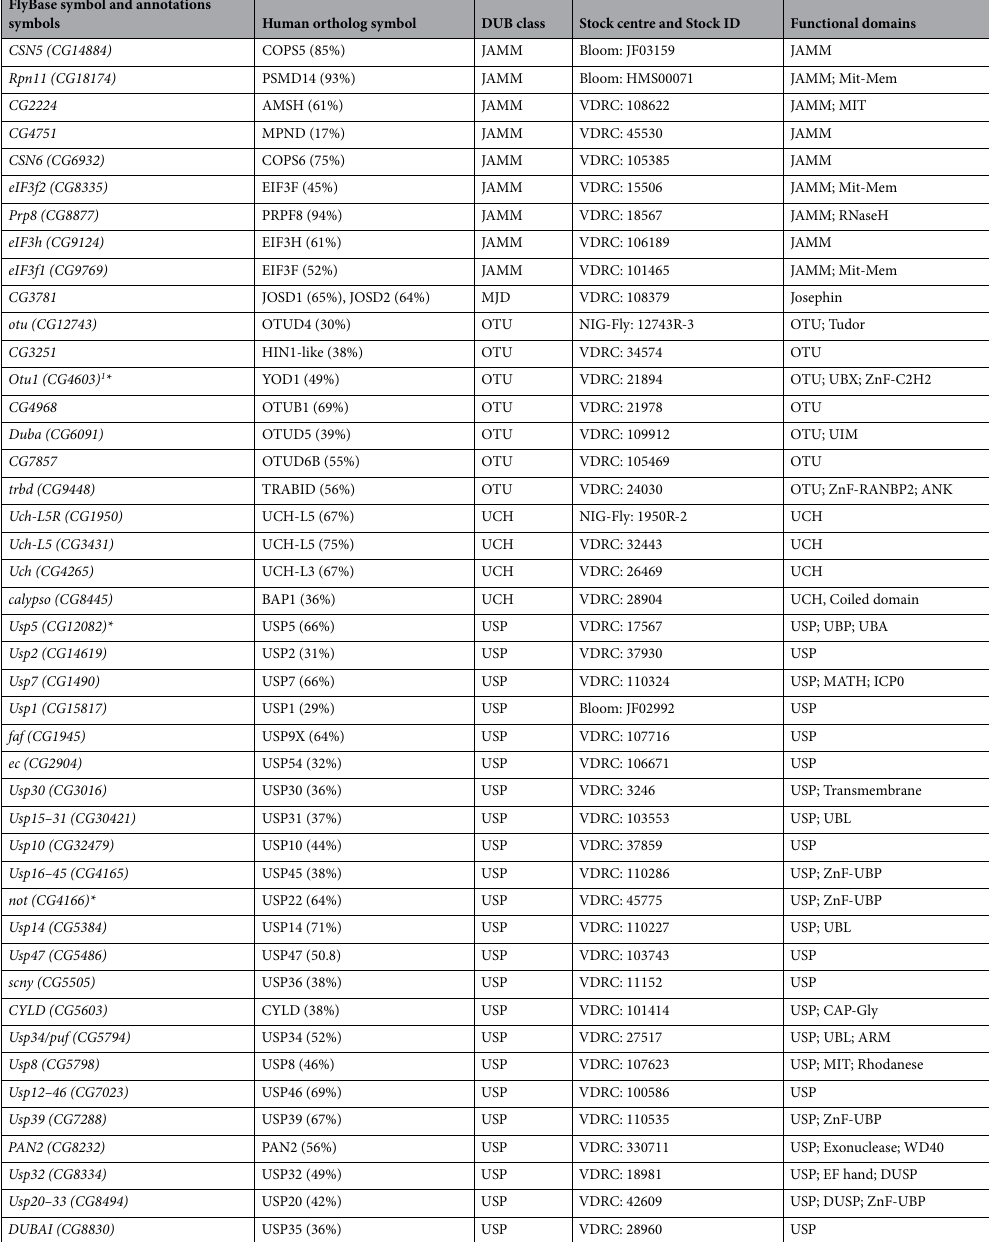
Table 1. A 44 Drosophila DUBs were selected for further tests in the RNAi screening. FlyBase symbol represents gene names based on the FlyBase database and next to FlyBase symbols, annotation symbols are labeled with CG numbers. Those DUBs which are annotated only with CG-prefixed numbers are labeled with a CG-prefix number only in FlyBase symbol and annotation symbols column. The second column shows the annotated human orthologs of the Drosophila DUBs. Next to the human orthologs, the average identity between Drosophila and human orthologs was labeled in brackets. The Stock centre and Stock ID column contains the ID number and the abbreviated name of the stock centre as follows: the Bloomington Drosophila Stock Center is labeled as Bloom, the Vienna Drosophila Resource Center is denoted to VDRC and the National Institute of Genetics is referred to as NIG-Fly. The last column, depicting the Functional Domains, demonstrates the conserved functional domains where the short names of domains are labeled as follows: ANK Ankyrin repeats domain, ARM armadillo repeat domain, CAP-Gly cytoskeleton-associated protein glycine-rich, DUSP domain in USP, ICP0 Infected cell protein 0, JAMM JAB1/MPN/Mov34 metalloenzyme, MATH meprin and TRAF homology domain, MIT microtubule interacting and transport, Mit-Mem mitochondorial membrane, OTU ovarian tumour deubiquitinase domain, RnaseH Ribonuclease H, UBA Ubiquitin-Associated domain, UBL Ubiquitin-like domain, UBP ubiquitin binding domain, UBX